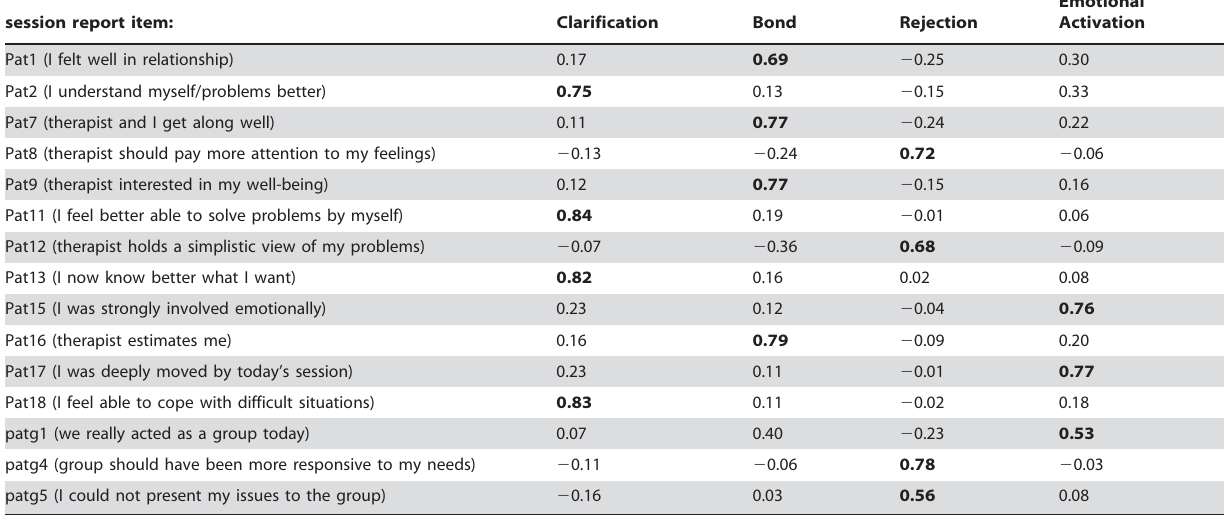
Table 1. Loadings of components.